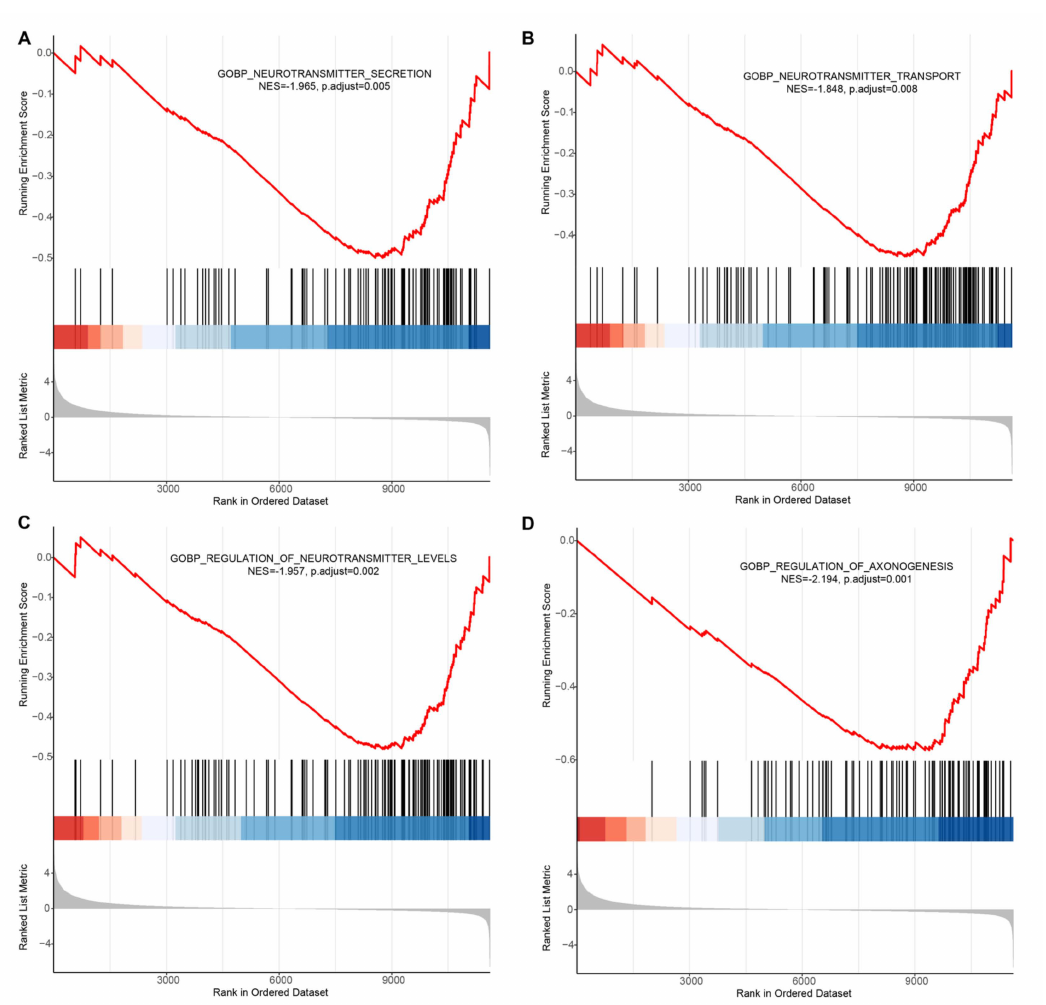
Figure 6. GSEA enrichment analysis. ( A ) Biological process of neurotransmitter secretion. ( B ) Biological process of neuro- transmitter transport. ( C ) Biological process of neurotransmitter levels regulation. ( D ) Biological process of axonogenesis regulation. In GSEA enrichment graphs, the curves represent the running sum of enrichment scores, the middle part of the graph shows the position of genes associated with specific pathways, and the bottom part of the graph shows how the fold change is distributed along with the gene list. The normalized enrichment score (NES) and the adjusted p -values were shown in the